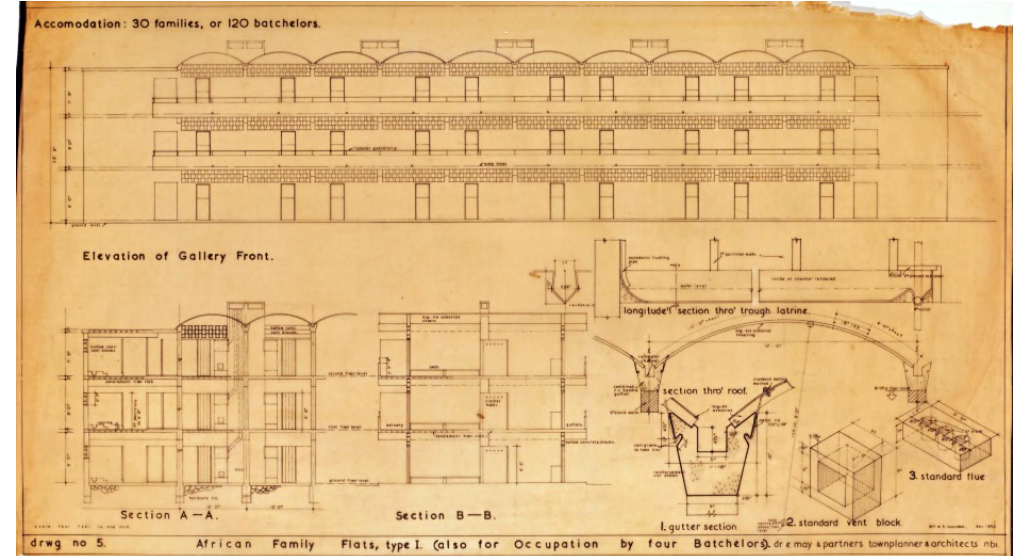
Figure 18. African family flats, apartment houses for small families, Satellite Port Tudor. Source: Herrel (2001).